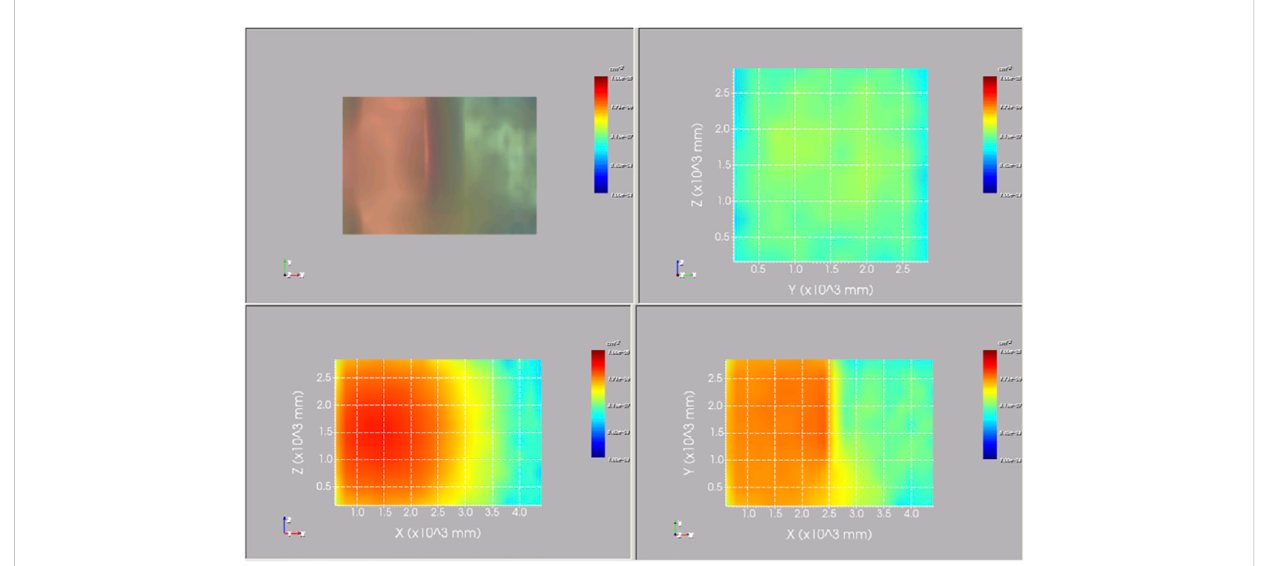
FIGURE 7 Schematic diagram of the photon fl ux distribution under a neutron source.